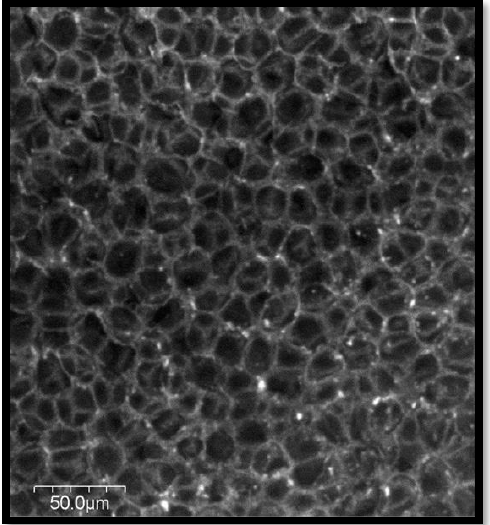
Figure 2. SEM images of ( A ) ground quill–PP composite, ( B ) ground quill–PP composite at 3.0 K · magnification, and ( C ) jute–PP composites. Reprinted/adapted with permission from Ref. [48].